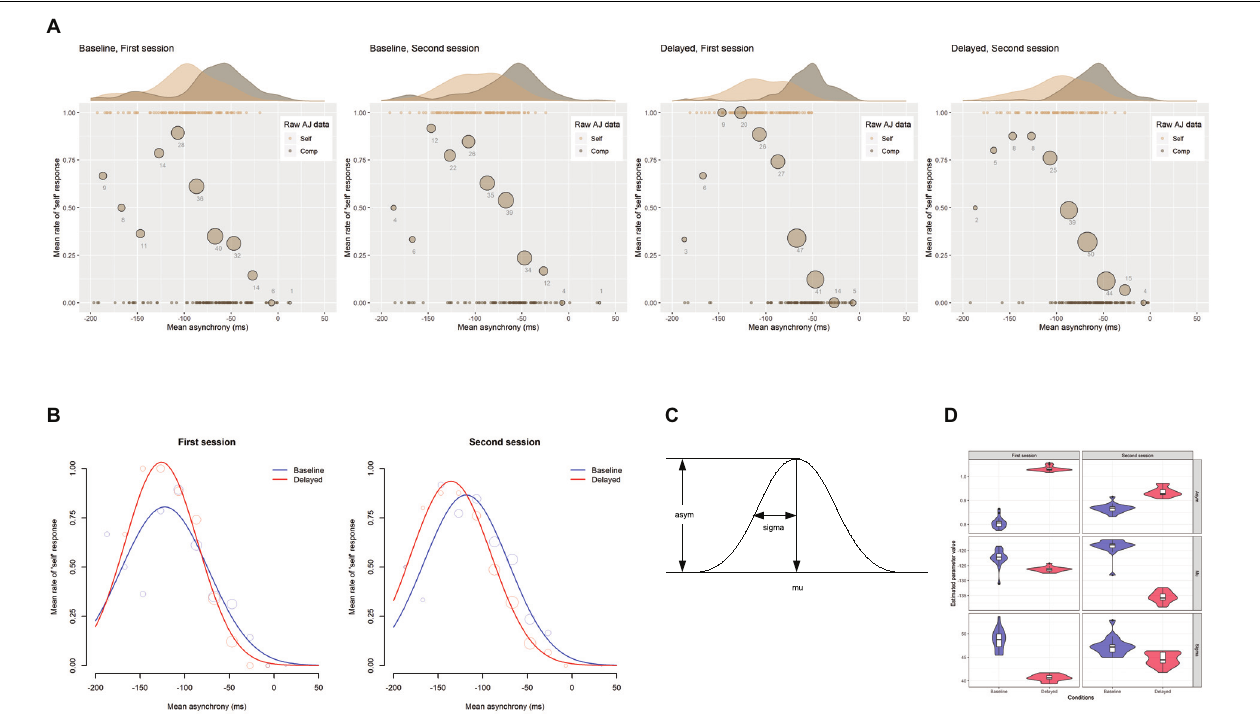
FIGURE 7 | Results from the analysis on a trial-by-trial basis about the agency judgment (AJ) data under the computer-controlled trials against the mean asynchrony. (A) Scatter plots of the raw AJ data against the mean asynchrony that is pooled across participants for each condition in two sessions. The probability density of the data is displayed as a curve outside the plot. The mean rate of the “self” responses against the 12 bins of the mean asynchrony is displayed as a circle within the plot. Size of the circle reflects the number of observations in the bin, which is also indicated by the digit below the circle. (B) Fitted Gaussian functions of the AJ against the mean asynchrony for each condition in two sessions. Mean rate of “self” response against the binned mean asynchrony was also displayed for reference. The size of the circle reflects the number of observations. (C) The asym, mu, and sigma are the parameters of Gaussian representing height, midpoint, and width. (D) Violin plots with boxplots representing the distribution of the estimated parameters from the 18 jackknife replications of the fitting of the Gaussian function to the AJ against the mean asynchrony.